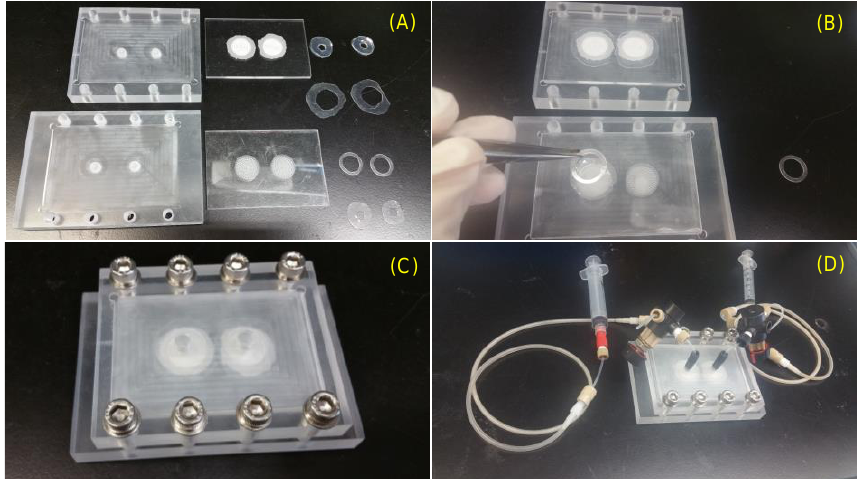
Figure 3. Assembly of VfB: ( A ) The VfB components: left column: jig to encase VfB; middle column: VfB cap and bottom; right column: O-rings to seal jig-cap, O-rings to seal cap-bottom, ring clips, O-ring to seal bottom-jig. ( B ) Fix a cell seeding membrane with a ring clip. ( C ) VfB encased in jig with screw security. ( D ) Connect perfusion tubing to VfB. Scale bar = 1 cm.